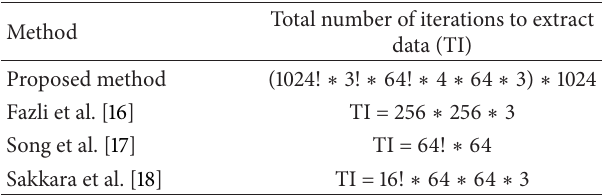
Table 3: Comparative